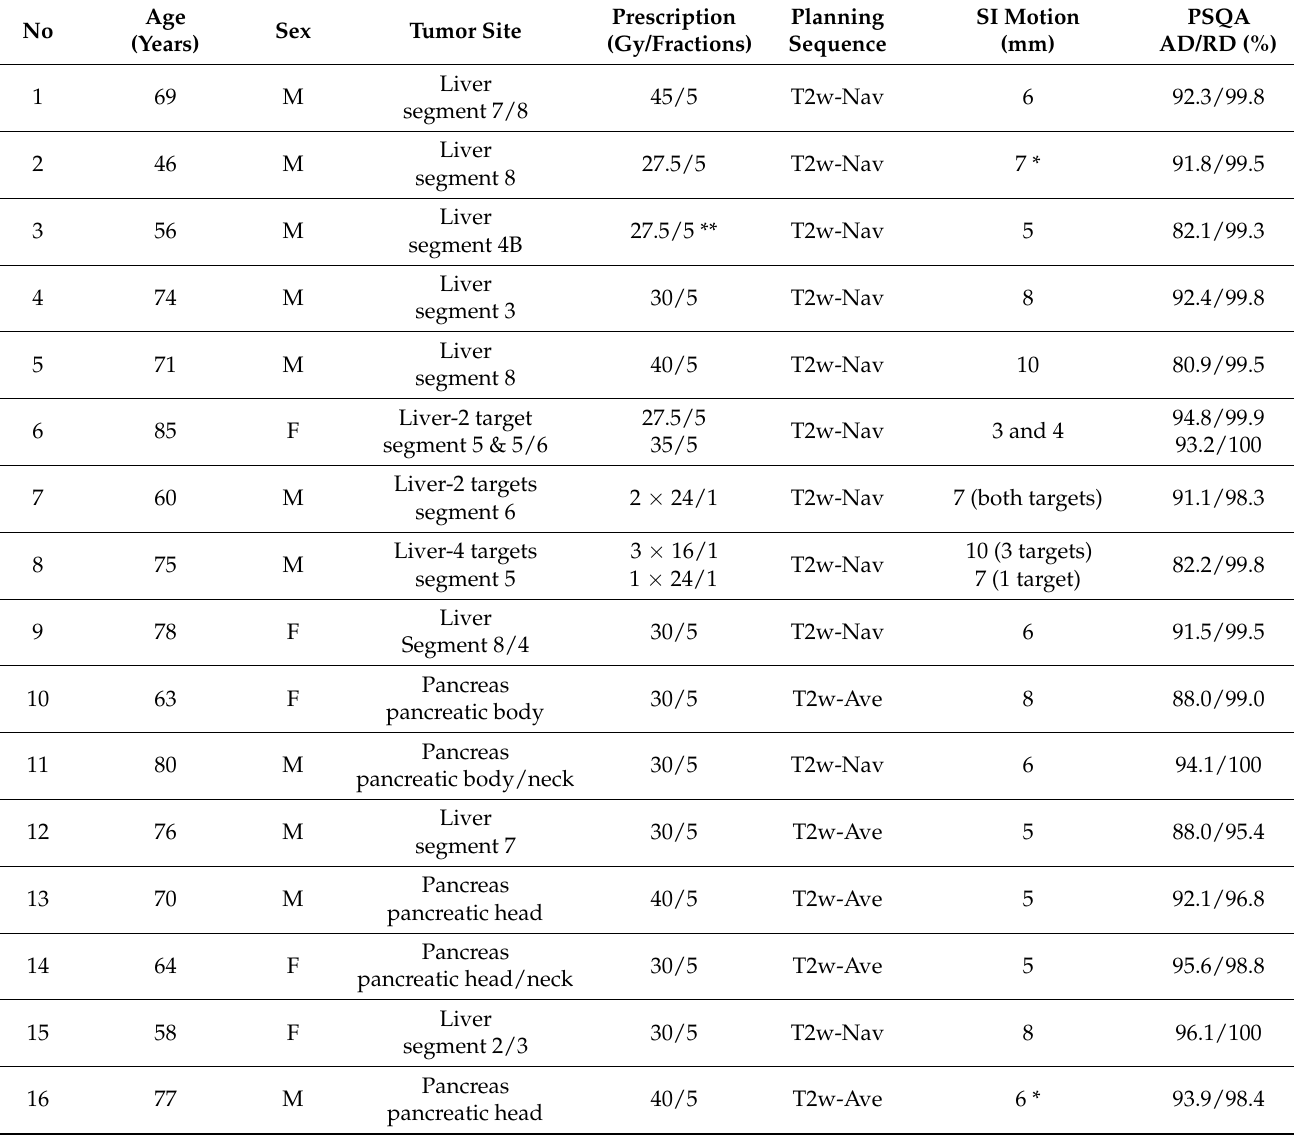
Table 1. Summary of patient information and specifics regarding the online adaptive treatment